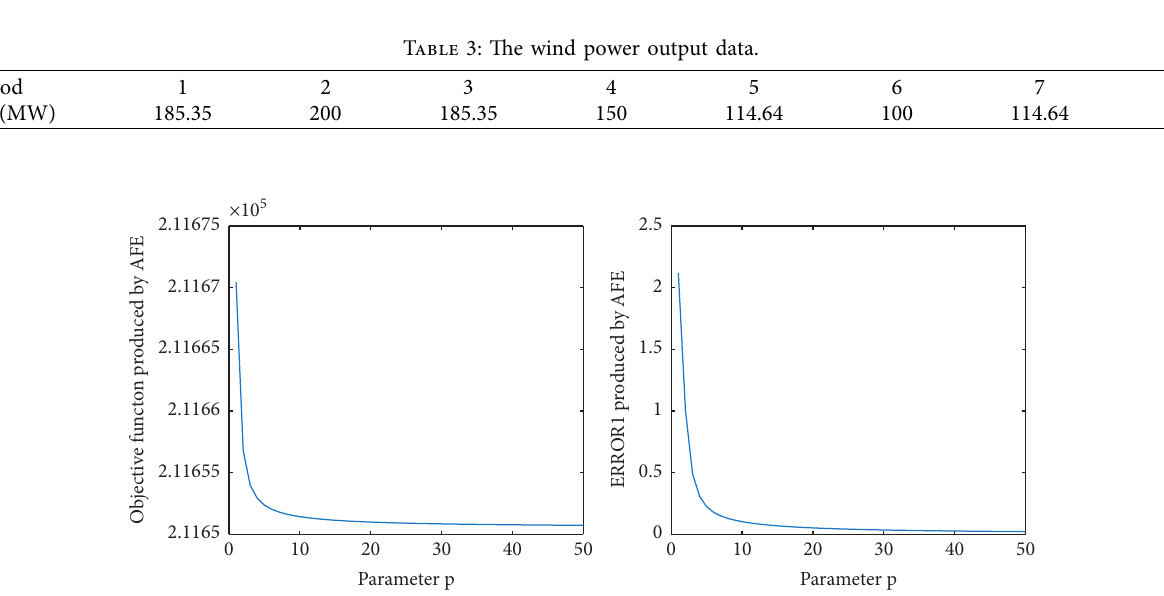
Figure 1: The trend of the objective function and ERROR1 produced by AFM with different p